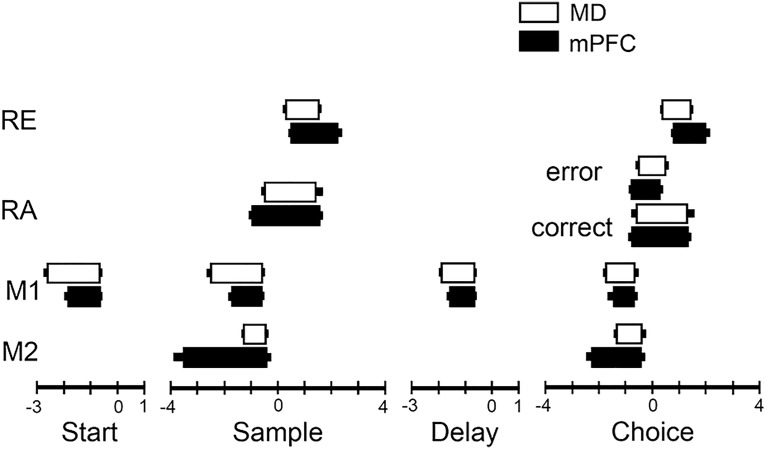
Temporal duration of reinforcement excitation (RE), reinforcement anticipation (RA), movement 1 (M1), and movement 2 (M2) in MD thalamus and mPFC. Thick bars represent the mean duration and thin bars the SEM. Separate results are plotted for RA for correct choices (followed by reinforcement) and errors (not followed by reinforcement). Onset was measured from when responses increased above the 99% confidence interval and offset from when responses fell below this level in individual PETH plots. These analyses were restricted to neurons that remained outside the 99% confidence interval throughout common periods of elevated activity identified in normalized population plots (see Figs. 8 and 9).